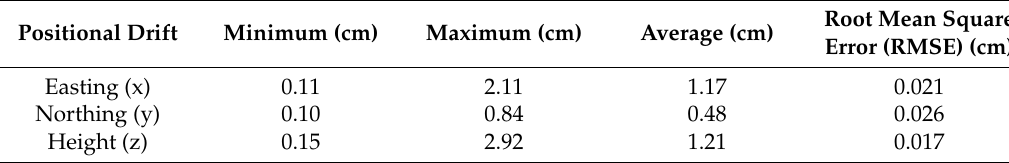
Table 2. Summary statistics for the RTK-GPS field evaluation.